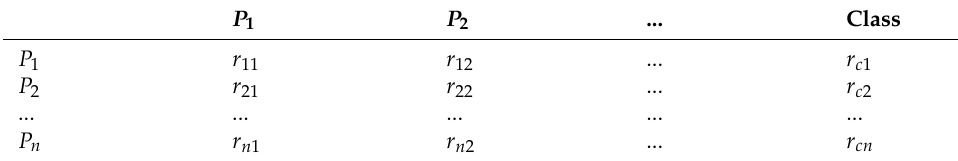
Table 2. This is the correlation coefficient matrix of several models. P 1 P 2 ...